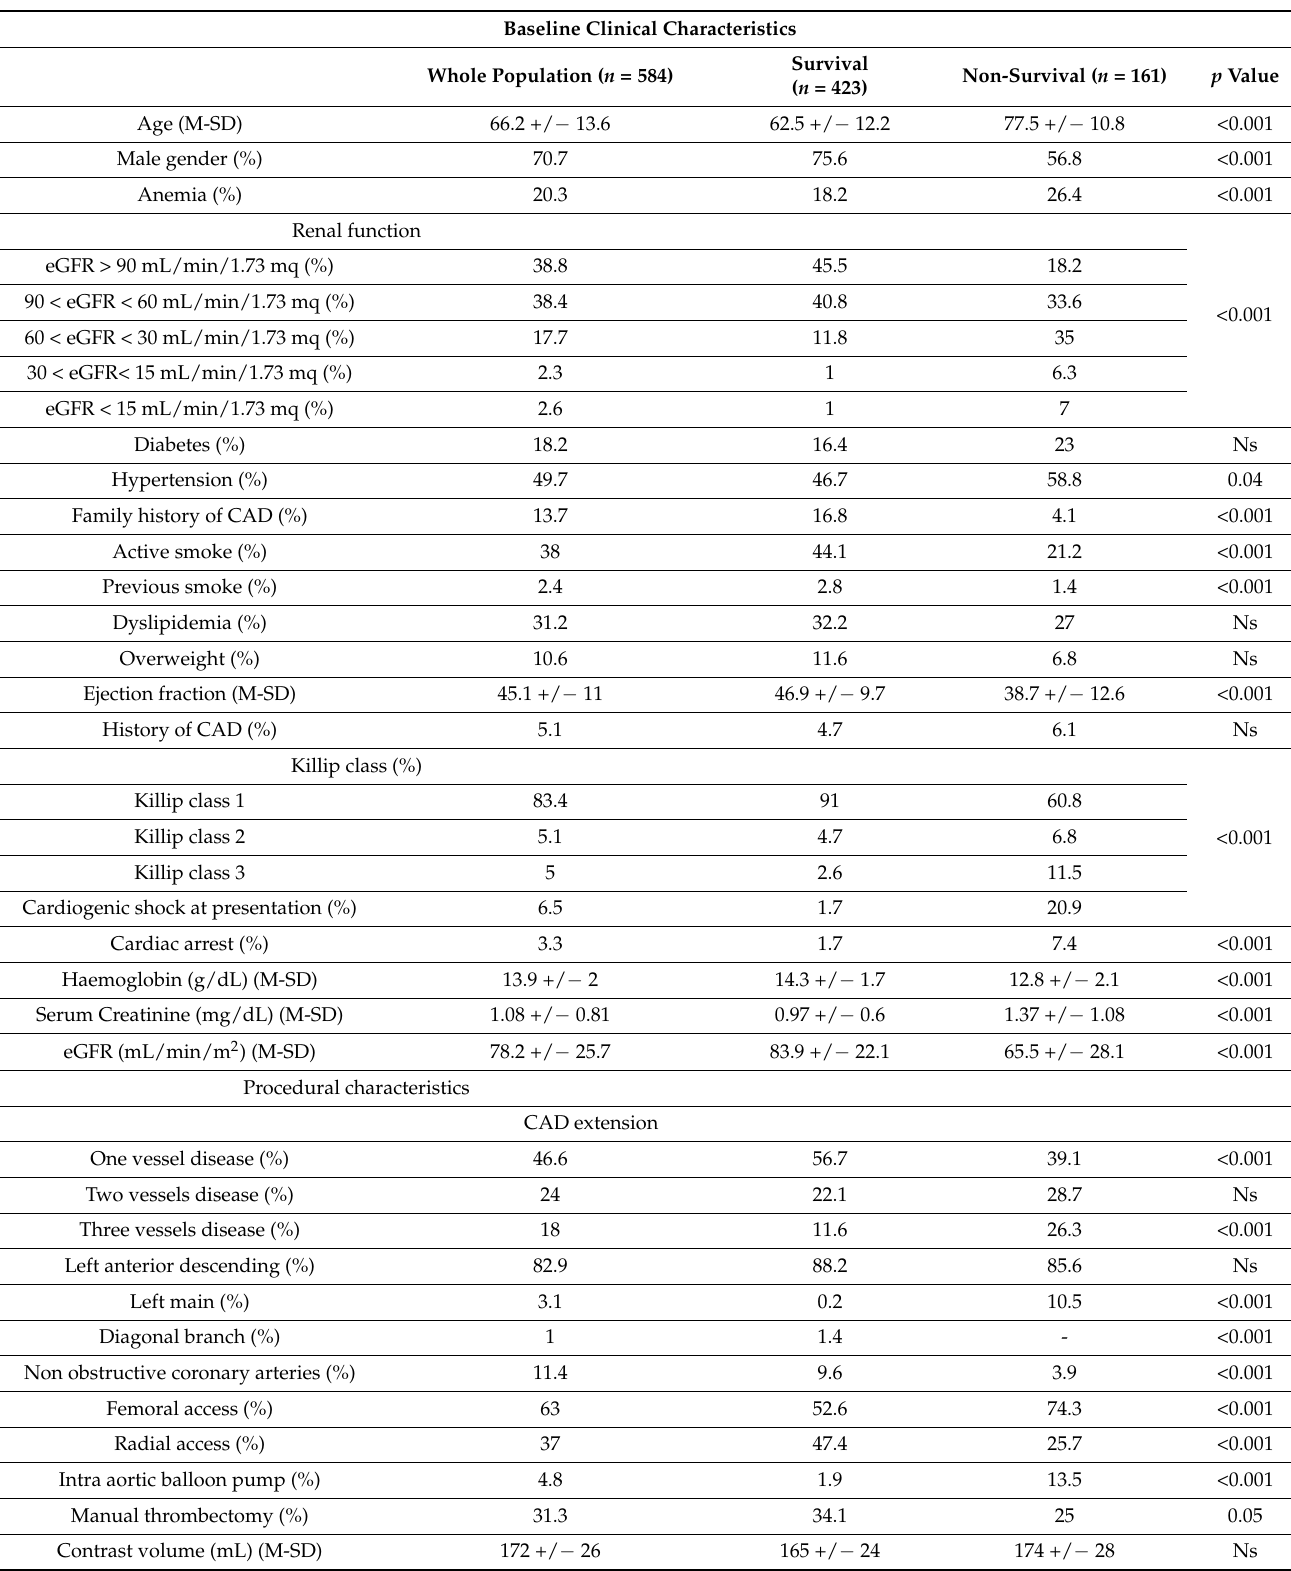
Table 1. Clinical and procedural